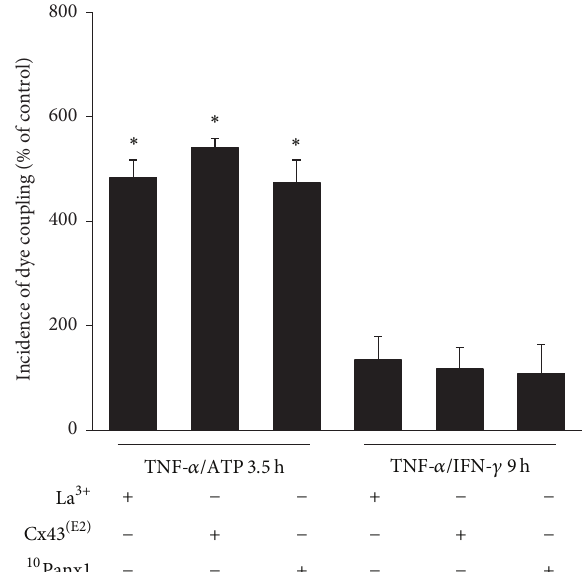
Figure6:BlockadeofHCspreventsupregulationofmicroglialgapjunctionalcommunicationinducedbyTNF- 𝛼 /IFN- 𝛾 ,butnotthatinduced by TNF- 𝛼 plus ATP. Effect on the incidence of dye coupling (IDC) in EOC20 cells treated with TNF- 𝛼 plus ATP for 3.5h or TNF- 𝛼 /IFN- 𝛾 for 9h in presence of HC blockers (200 𝜇 M La 3+ , 1:500 Cx43 (E2) antibody, 200 𝜇 M 10 Panx1). Data is expressed as percentage of IDC under control conditions (dashed line) and corresponds to the mean ± SEM, 𝑛 = 4 . ∗ 𝑃 < 0.05 versus control